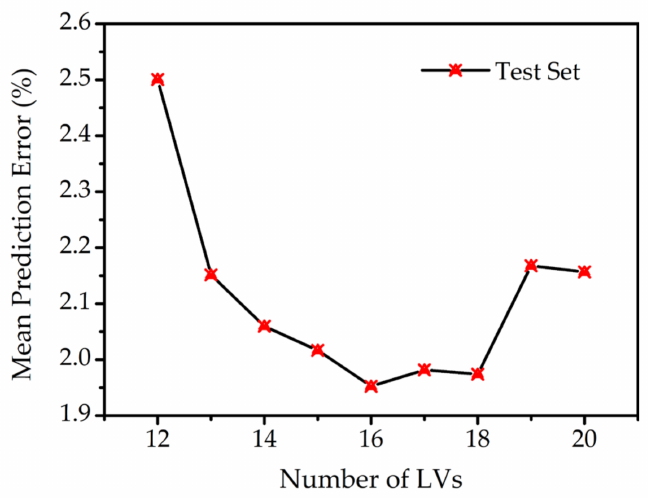
Figure 4. Mean prediction error with different numbers of LVs.